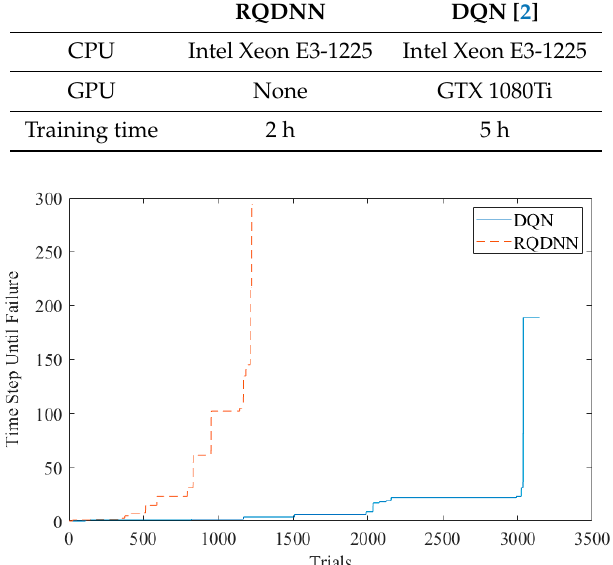
Figure 15. Comparison results of RQDNN and Deep Q-learning Network (DQN) [2] training with the Flappy Bird game.